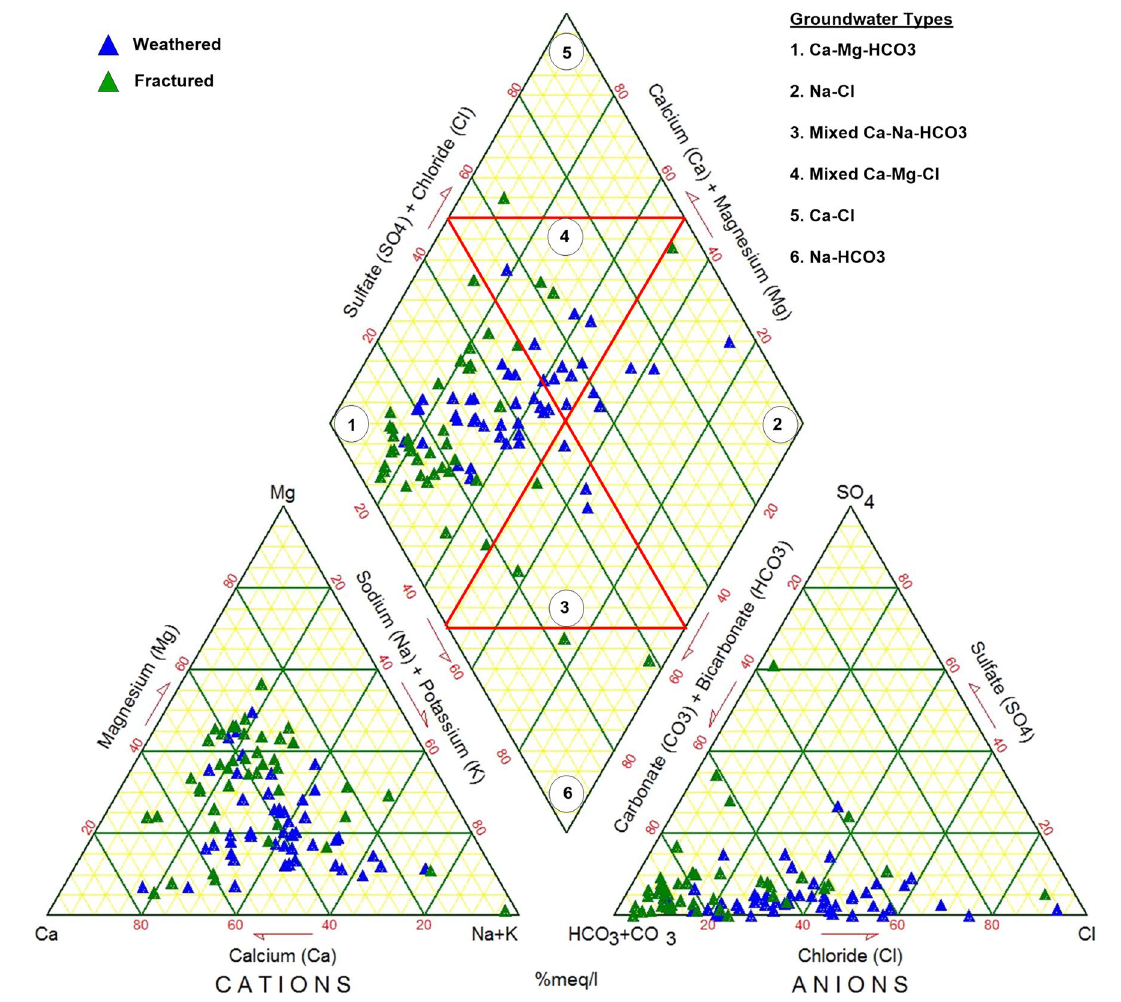
Fig. 4 Piper’s trilinear diagram showing plots of groundwater samples Table 4 Details of groundwater samples from charnockites belonging to different groundwater types Sl.